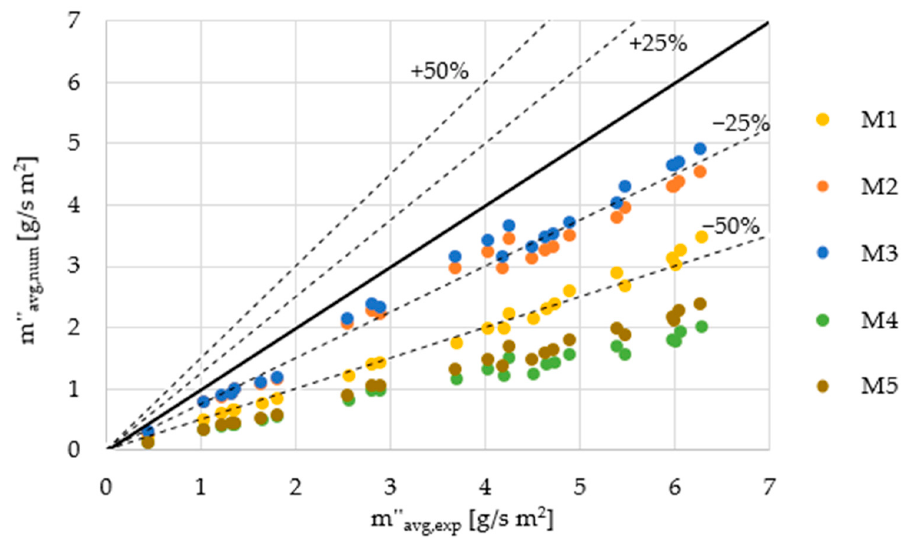
Figure 5. Comparison between our experimental and calculated condensation mass fluxes, obtained using existing models [3,22,25,26]. Table 2. Existing models used for the comparison with the experimental results for the case of the condensation of water vapour on vertical flat plates.